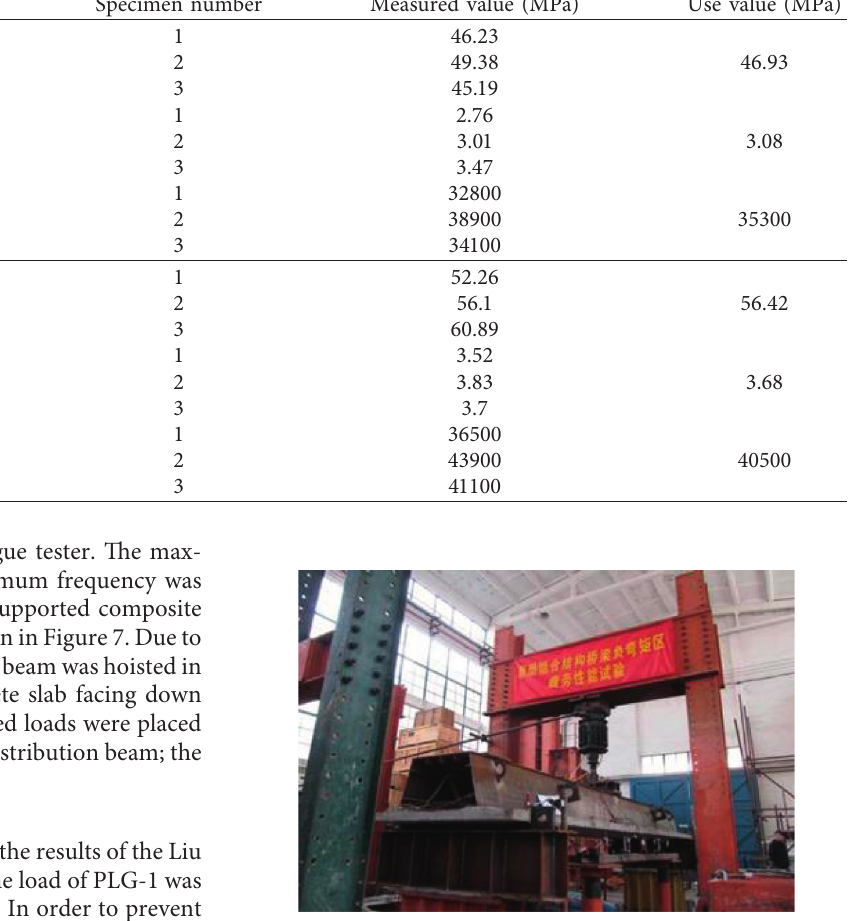
Figure 7: Test beam loading site.